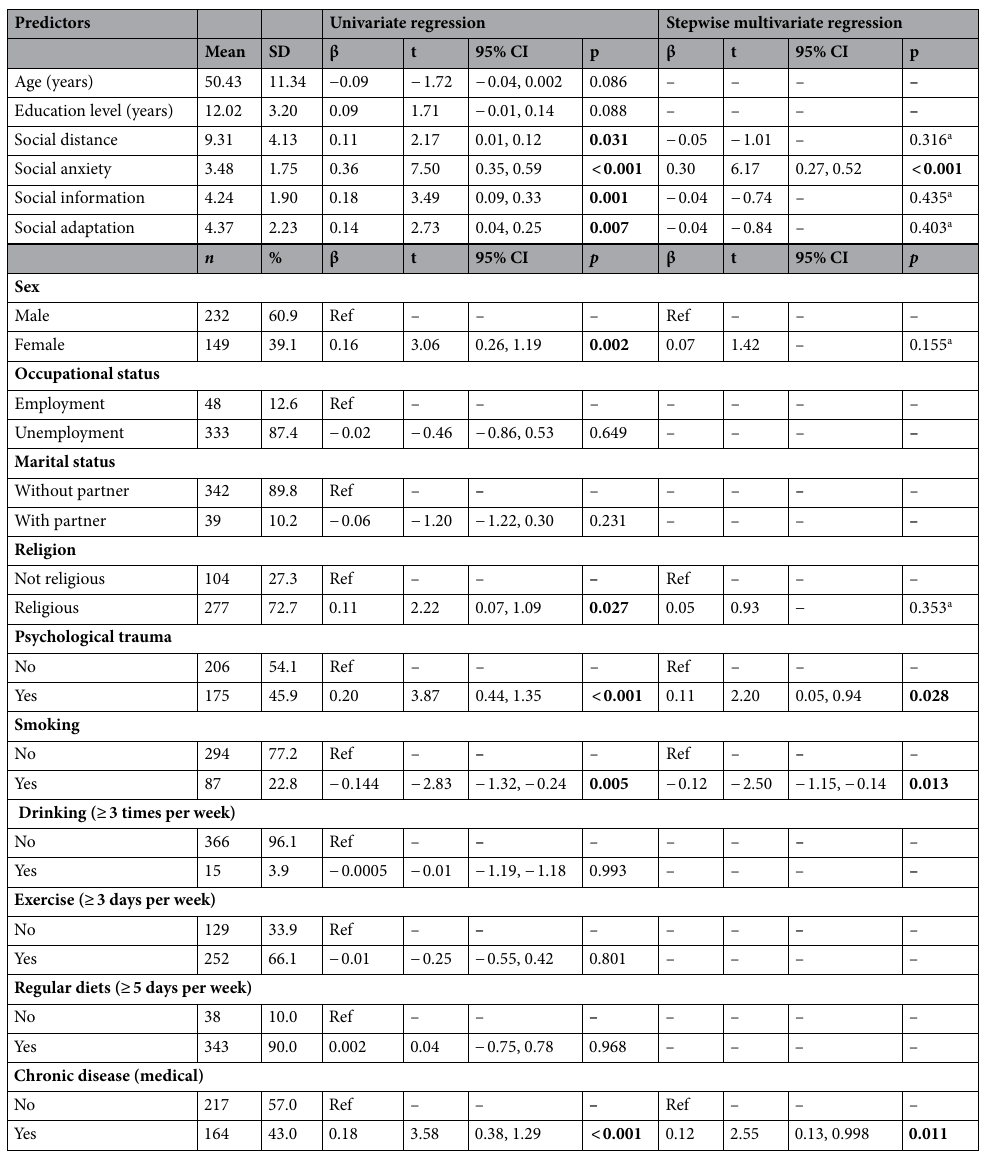
Predictors for the level of sleep disturbance. The results of the linear regression are presented in Table 1. The results of the univariate linear regression revealed that higher levels of sleep disturbance were sig- nificantly associated with higher levels of social distance (standardized coefficients β = 0.11; P = 0.031), higher levels of social anxiety (β = 0.36; P < 0.001), higher levels of social information (β = 0.18; P = 0.001), higher levels of social adaptation (β = 0.14; P = 0.001), female subjects (β = 0.16; P = 0.002), subjects with religion (β = 0.11; P = 0.027), subjects with a history of psychological trauma (β = 0.20; P < 0.001), chronic disease (β = 0.18; P < 0.001), and those who did not smoke (β = − 0.14; P = 0.005). The stepwise linear regression excluded level of social distance, social information, social adaptation, female, and religion subjects. The final model for the significant factors presented as follows: higher level of social anxiety (β = 0.30; P < 0.001), history of psychological trauma (β = 0.11; P = 0.028), chronic disease (β = 0.12; P = 0.011), and those who did not smoke (β = − 0.12; P = 0.013). The multivariate linear regression with 1000 bootstrapping methods demonstrated the same pattern for the independent associators for the level of sleep disturbance (Sup- plementary Table S5). Predictors for the level of COVID‑19 related psychological distress. In Table 2, the results of the univariate linear regression revealed that higher levels of social distance (β = 0.16; P = 0.002), higher lev-